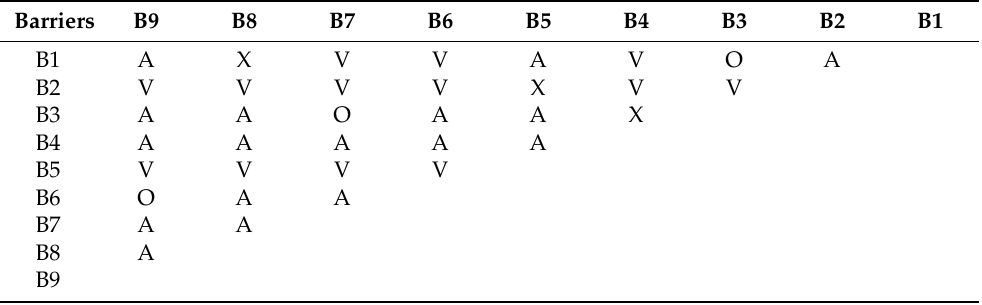
Table 4. Structural self-interaction matrix (SSIM) of socio-political sustainability barriers.